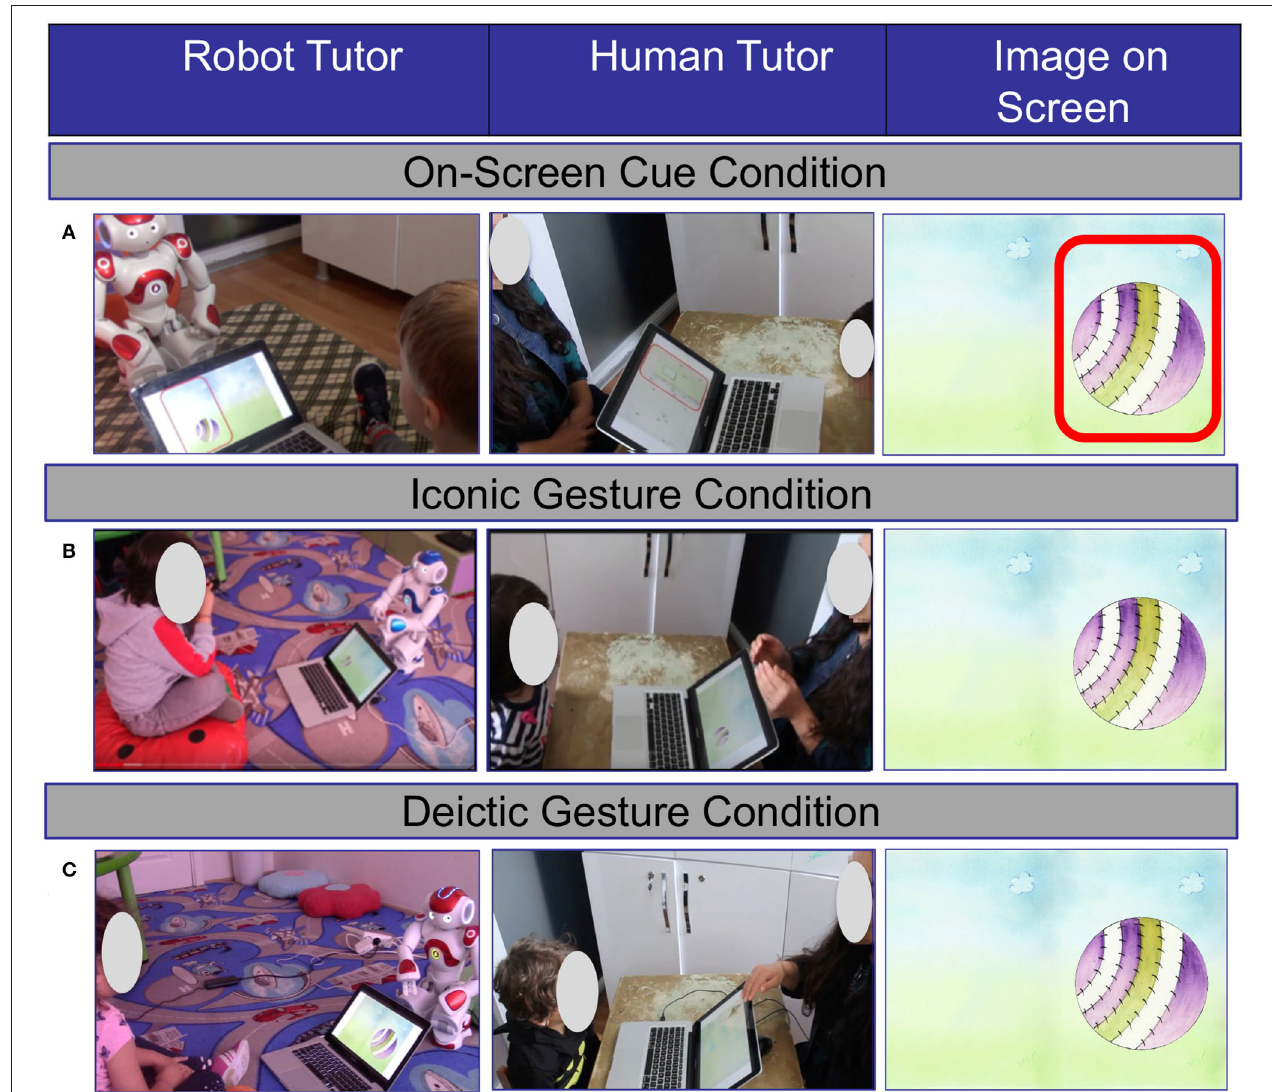
FIGURE 1 | Study design when teaching the word small . (A) In the Screen Cue condition, no gesture is performed, and a red rectangle appears around the object to draw attention to the screen. (B) In the Iconic Gesture condition, an iconic gesture is performed. (C) In the Deictic Gesture condition, the experimenter points to the object on the